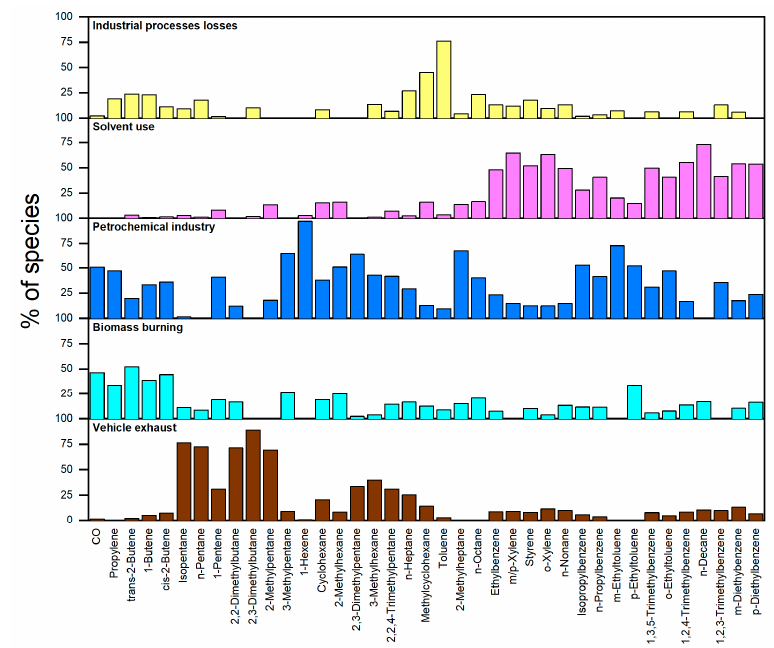
Figure 9. Source profiles derived from the PMF model at the WQS site.